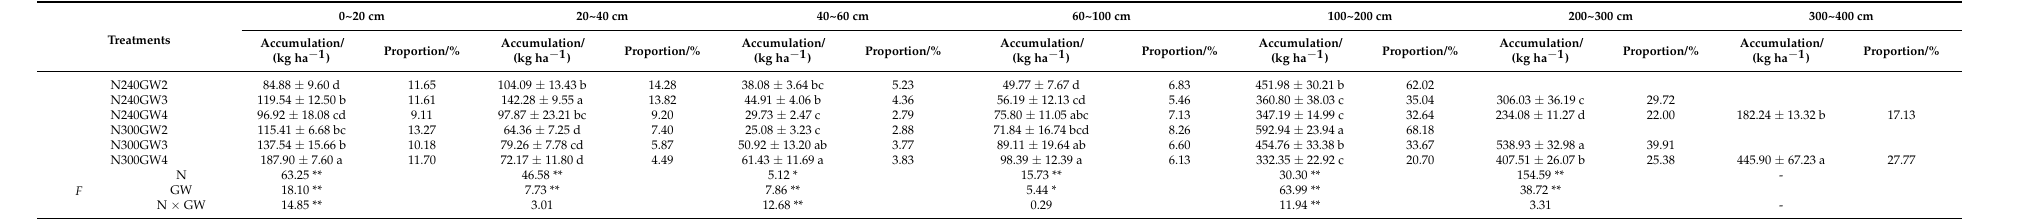
Note: Different lowercase letters in the same column indicate significant differences among treatments at the p < 0.05 level; The * after the values in the table indicates significant differences between treatments at the p < 0.05 level, and ** indicates very significant differences at the p < 0.01 level, the same below. Table 5. Residual soil nitrate accumulation in each soil layer in winter